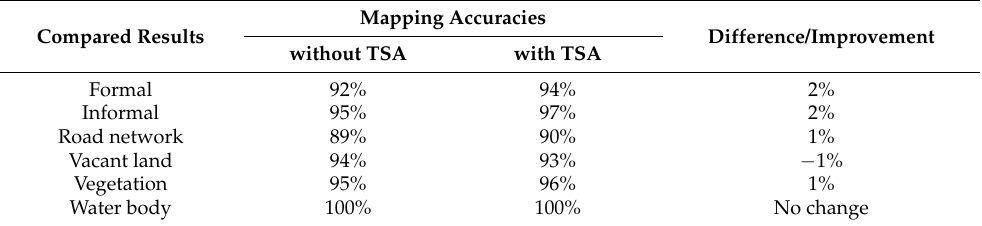
Figure 6. The results of the predicted classes using object-based ML with TSA classification. Table 3. Summary of the accuracy assessment results obtained with and without TSA using object- based ML and